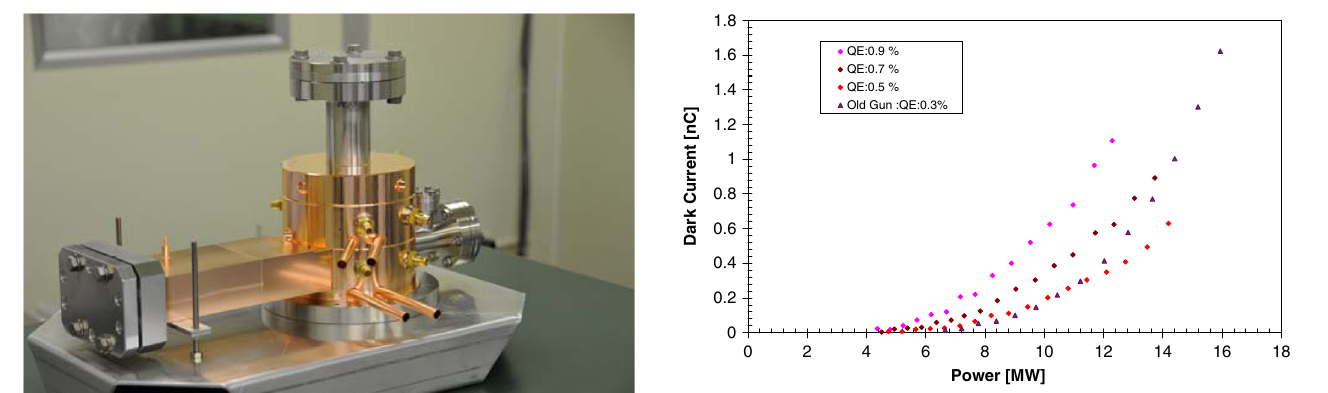
FIG. 5. Complete rf gun after the final tuning. A pair of tuners is positioned just above the water-cooling pipes in each cell. Similar pairs are positioned on the diametrically opposite side.